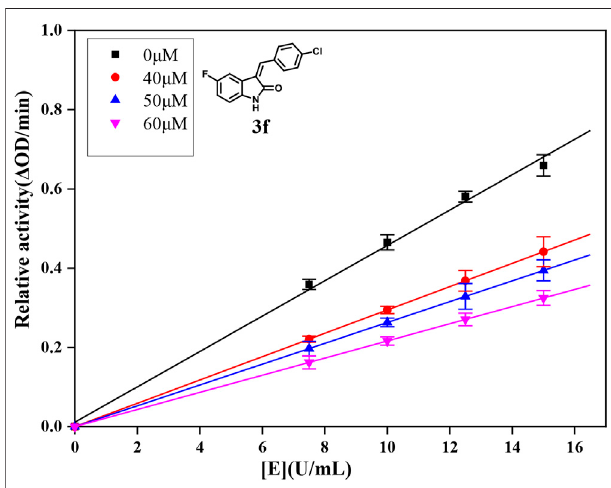
FIGURE 1 | Inhibition mechanism determination of compound 3f on α -